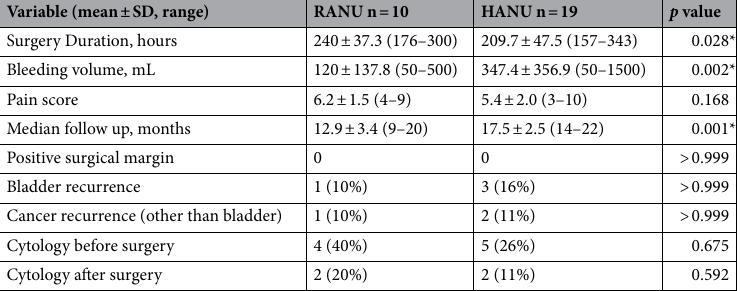
Table 2. Perioperative and Oncological Outcome of UTUC Patients. *p < 0.05 indicates statistical significance.